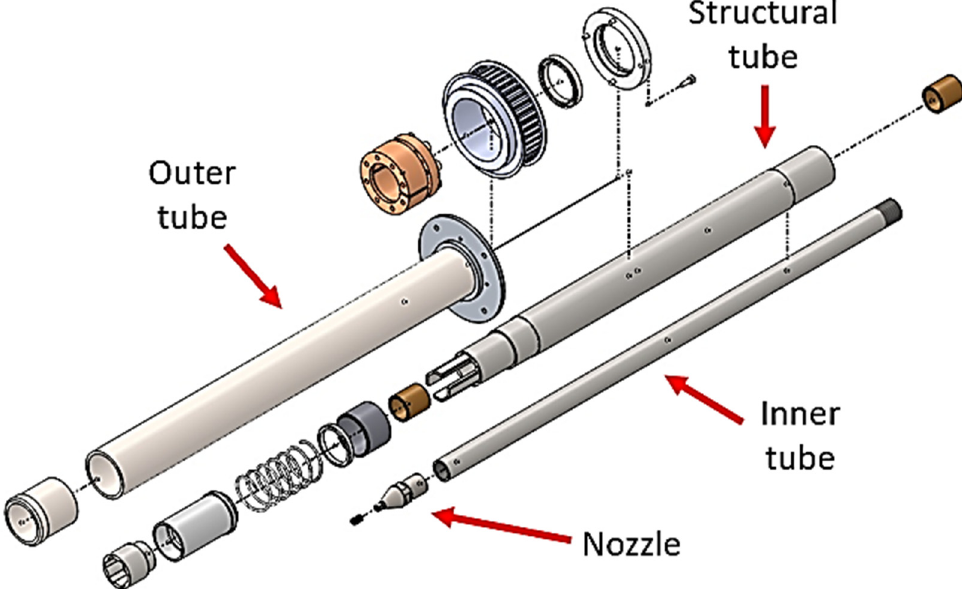
Figure 7. “Shaft connector” sub-assembly’s exploded view.